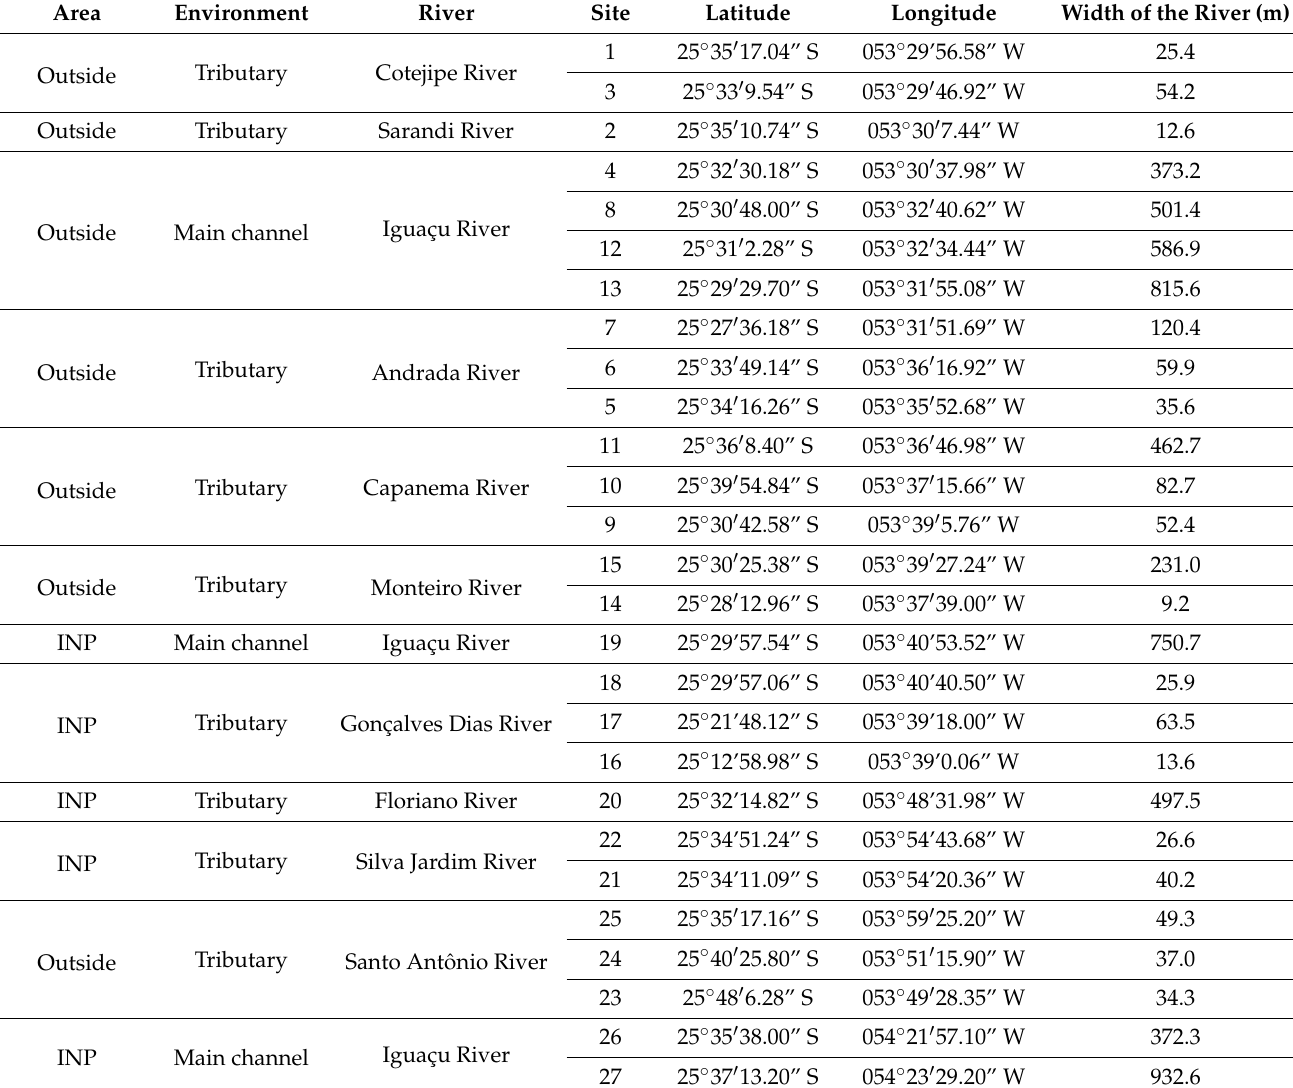
Table 1. Sampling sites’ characteristics in the protected area of the Iguaçu National Park (INP) and outside the INP, namely, in the lower Iguaçu basin downstream of Salto Caxias Dam and upstream of Iguaçu Falls.